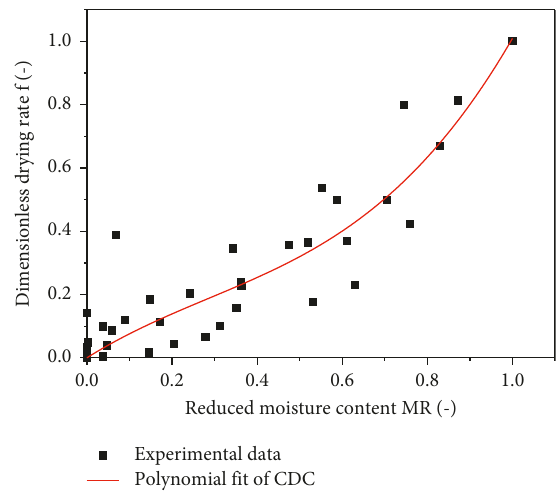
Figure 5: Characteristic drying curve of Crocus sativus L. Table 3: Statistical parameters for each model according to the drying